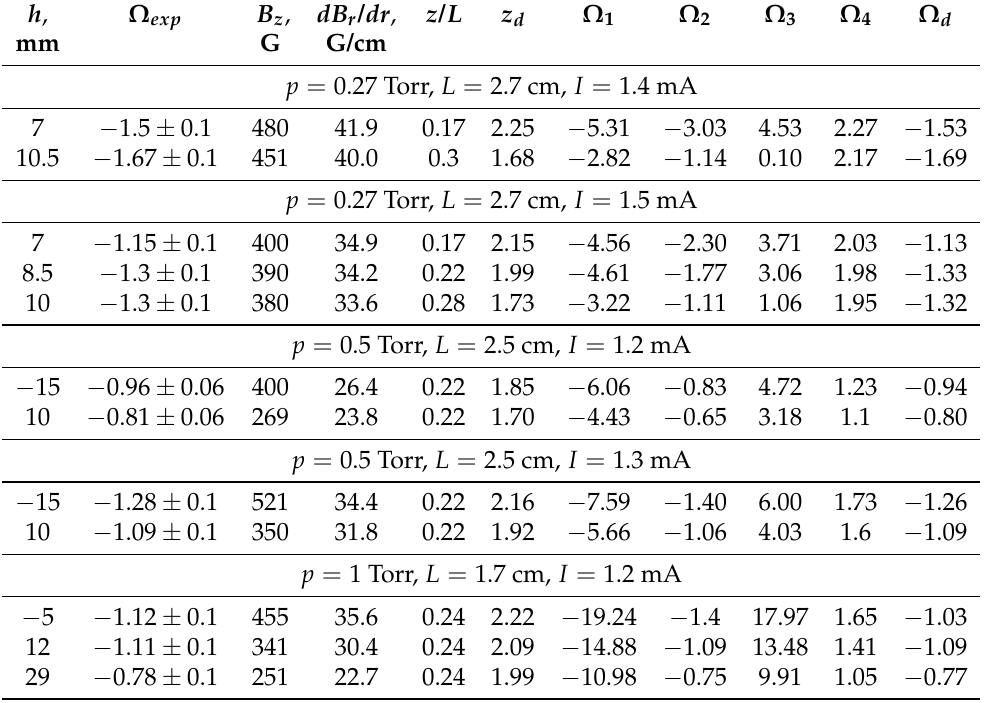
Table 1. Angular velocity and its components for a dusty structure in magnetic fields. Comparison of estimations with experimental